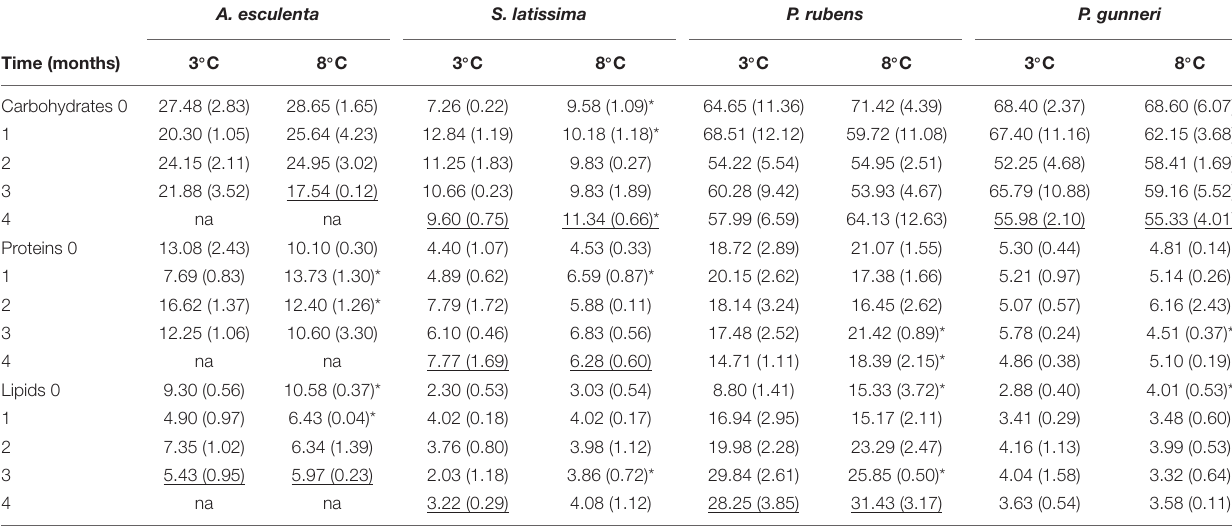
TABLE 3 | Total carbohydrates, proteins and lipid content (in mg g − 1 FW) measured during the dark period